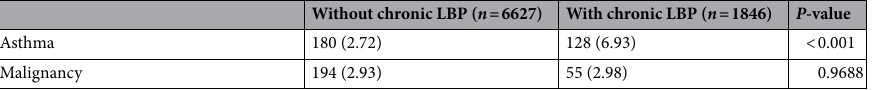
Table 1. General characteristics according to chronic LBP. Values are expressed as the mean ± SD or number (proportion). BMI body mass index, LBP low back pain. P < 0.05 was taken to indicate statistical significance.